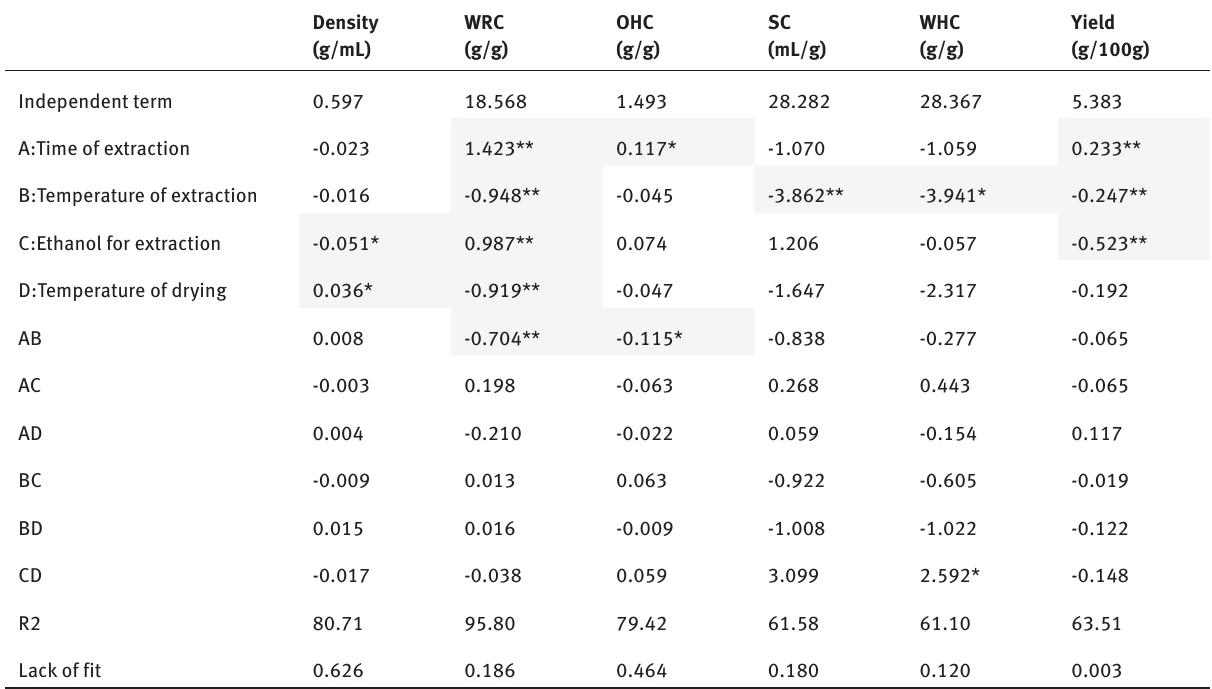
Table 3: Coefficients of regression and ANOVA for properties of DF obtained with convective air drying